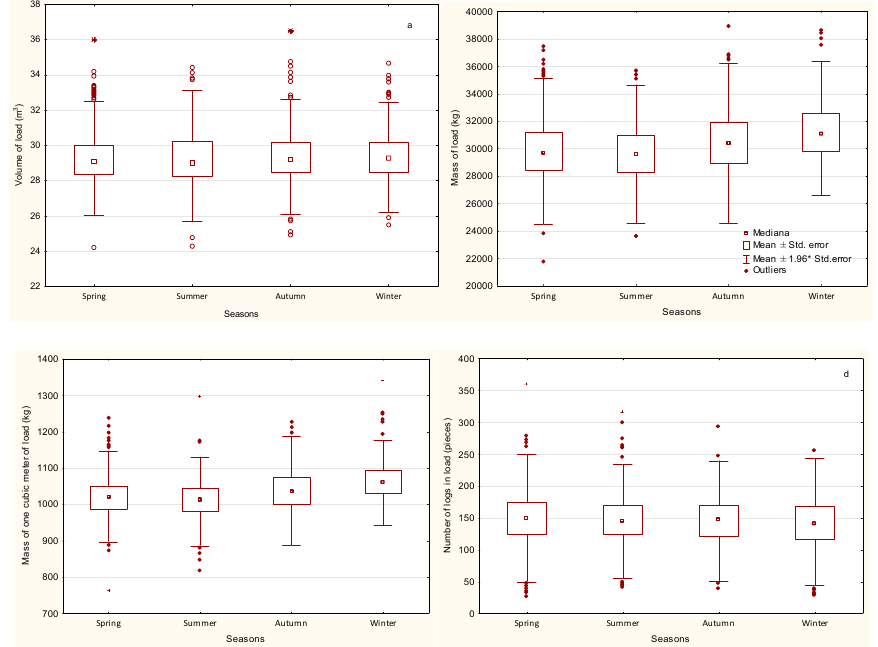
Figure 3. Comparison of the average values characterizing the timber loads depending on the time of timber transport by season. ( a ) load volume, ( b ) load mass, ( c ) mass of 1 m 3 , ( d ) number of logs (pieces).